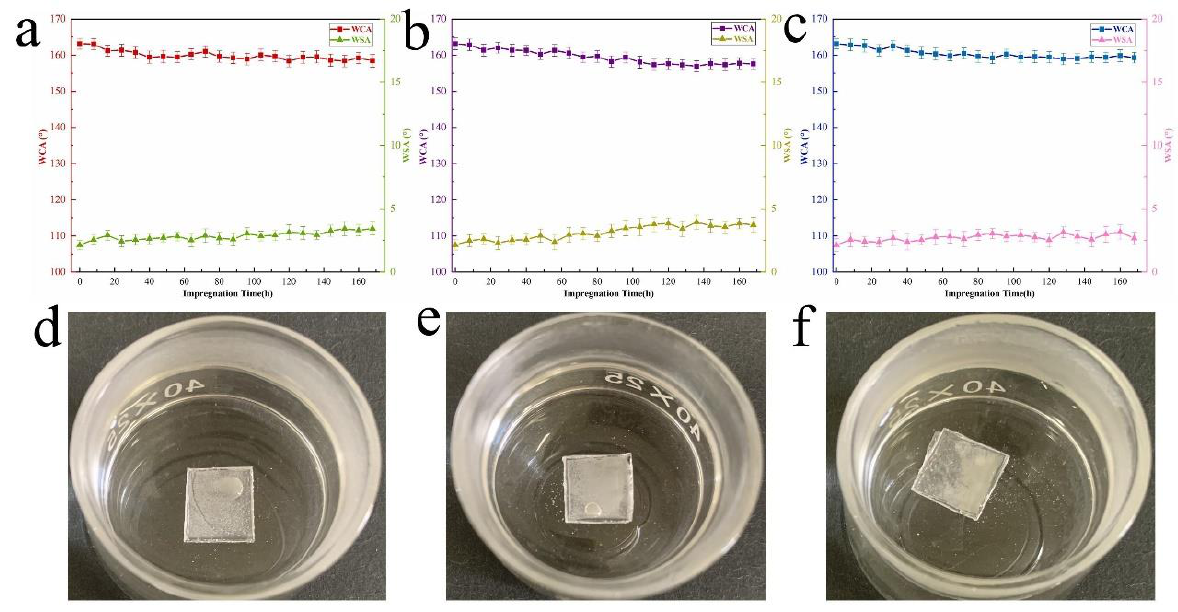
Figure 4. ( a ) WCA and SA variation trend of coating C5 immersed in HCl solution; ( b ) WCA and SA variation trend of coating C5 immersed in NaOH solution; ( c ) WCA and SA variation trend of coating C5 immersed in NaCl solution; ( d ) photograph of sample immersion state in HCl solution; ( e ) photograph of sample immersion state in NaOH solution; ( f ) photograph of sample immersion state in NaCl solution. In ( a – c ), WCA is the abbreviation of Water Contact Angle and SA is the abbreviation of Slip Angle,